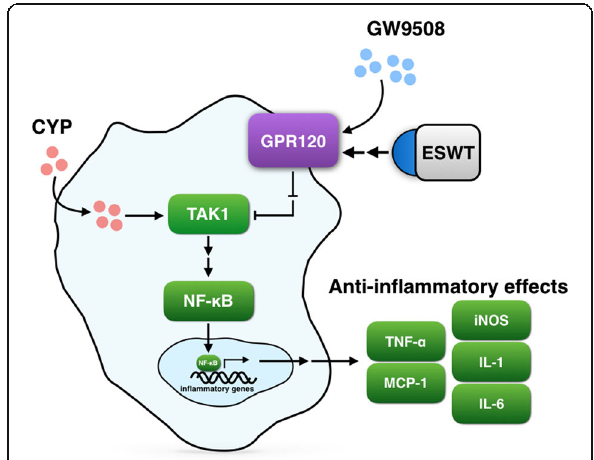
Fig. 10 Anti-inflammatory effects mediated by G-protein coupled receptor 120 (GPR120) in an experimental setting of interstitial cystitis. Stimulation of GPR120 through GPR120 agonist (i.e., GW9508) and extracorporeal shock wave treatment (ESWT) causing inhibition of transforming growth factor beta-activated kinase 1 (TAK1) and nuclear factor transcription factor (NF- κ B), resulting in suppressed expressions of tumor necrosis factor- α (TNF- α ), monocyte chemoattractant protein-1 (MCP-1), iNOS = inducible nitric oxide synthase as well as interleukin (IL) 1 and 6. Protein-protein interaction: activation or interaction ( → ); inhibition ( ),